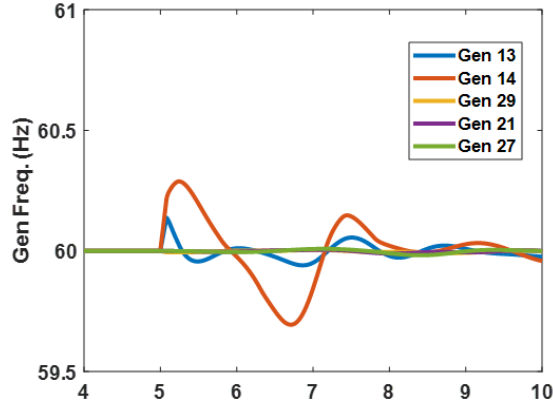
Figure 18. Speed of selected generators in the